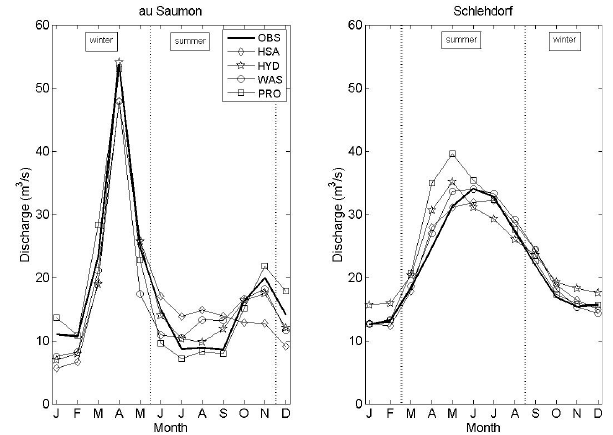
Fig. 6. Observed and simulated (forced by stations data) hydro- graphs for au Saumon and Schlehdorf over the reference